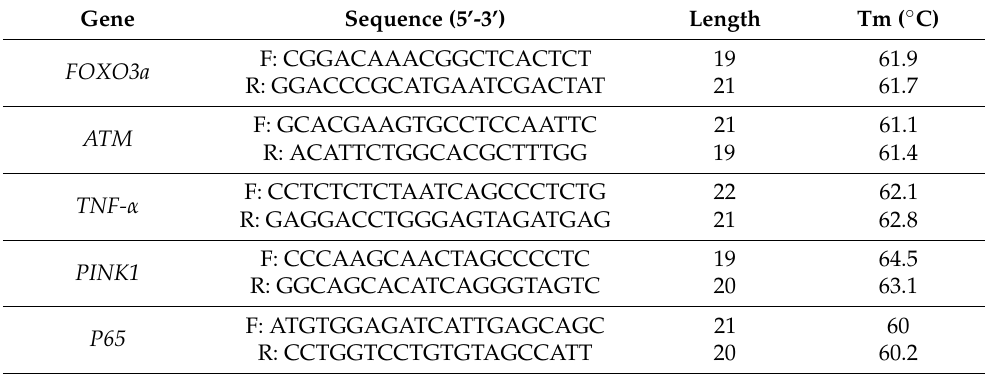
Table 3. Primer sequences used for